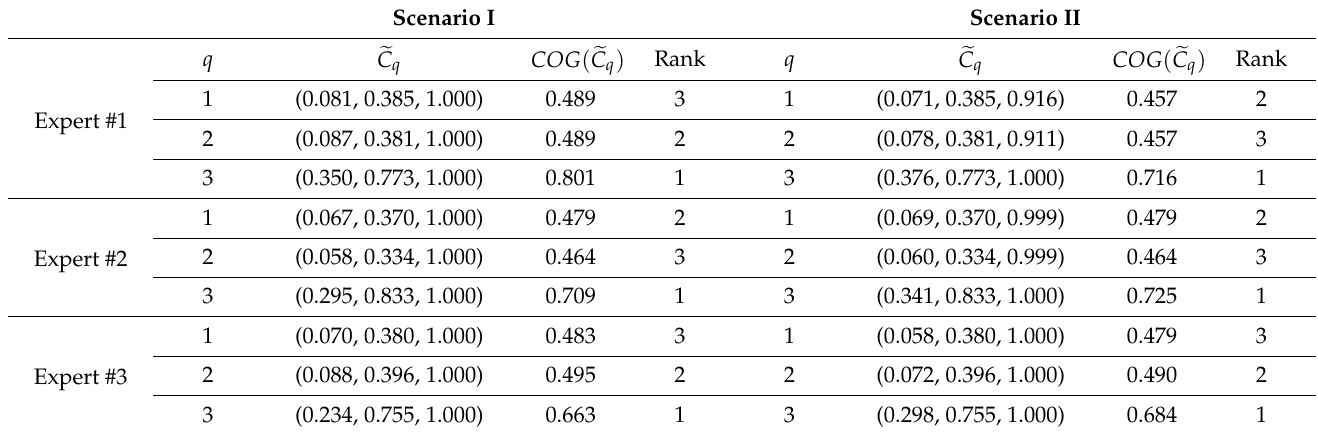
Table 6. Comparison results.